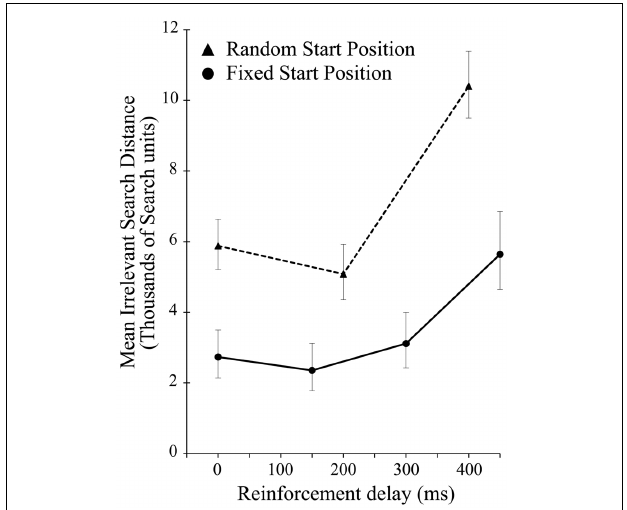
FIGURE 5 | Mean irrelevant pre-discovery distance (and standard error) for the 3 levels of reinforcement delay in experiment 2 (shown as dotted line). The results from experiment 1 (solid line) are also plotted for